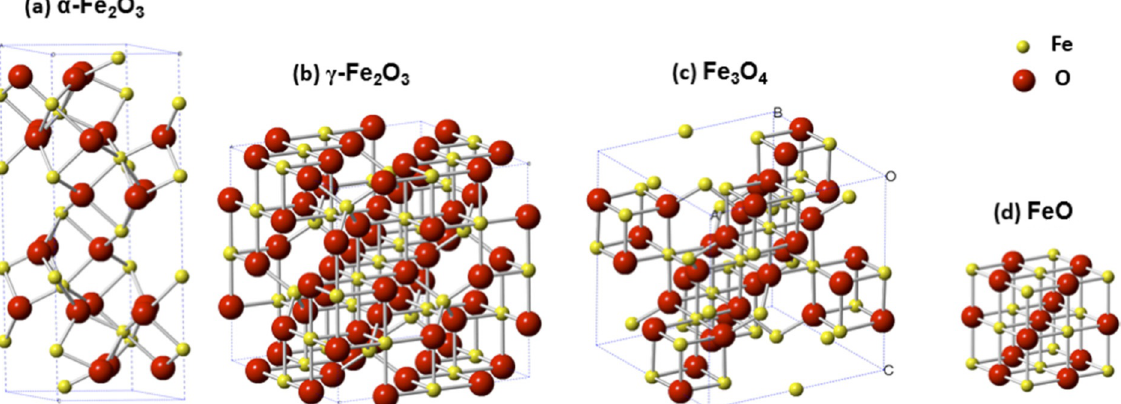
Figure 1. Representation of crystallographic unit cells of four major iron oxides species: ( a ) Hematite— α -Fe 2 O 3 , ( b ) maghemite— γ -Fe 2 O 3 , ( c ) magnetite—Fe 3 O 4 , and ( d ) wüstite—FeO. Image taken with permission from Zhu et al., 2016 [3].